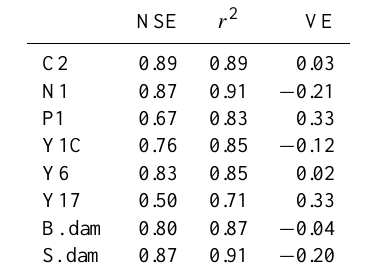
Table 2. Model performance evaluated by Nash–Sutcliffe efficiency (NSE), coefficient of determination ( r 2 ) and relative volume error (VE) for river discharges (1980–2011) at gauging stations and two dam sites (B. dam: Bhumibol dam, S. dam: Sirikit dam).